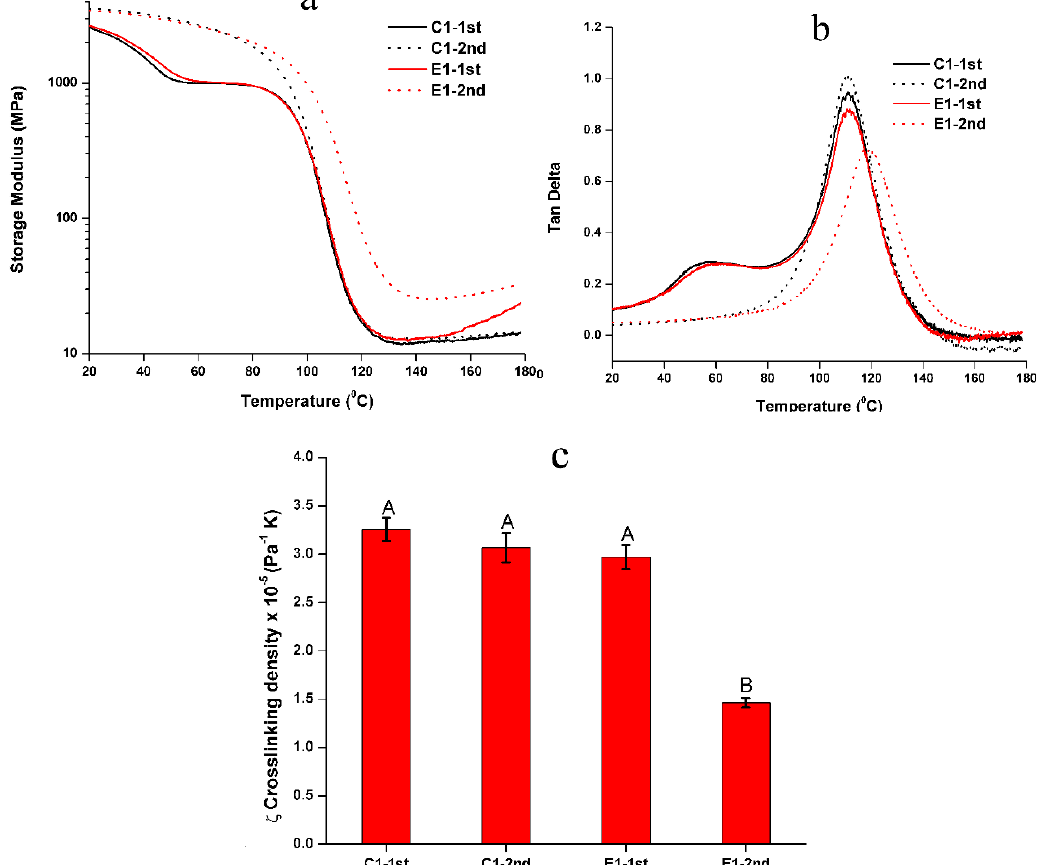
Figure 2. Representative ( a ) storage modulus and ( b ) tan δ vs. temperature of the non-treated C1 and E1 in two-cycle DMA test, and ( c ) the calculated relative crosslinking density (the same letter indicates no statistically significant difference at the 0.05 level).